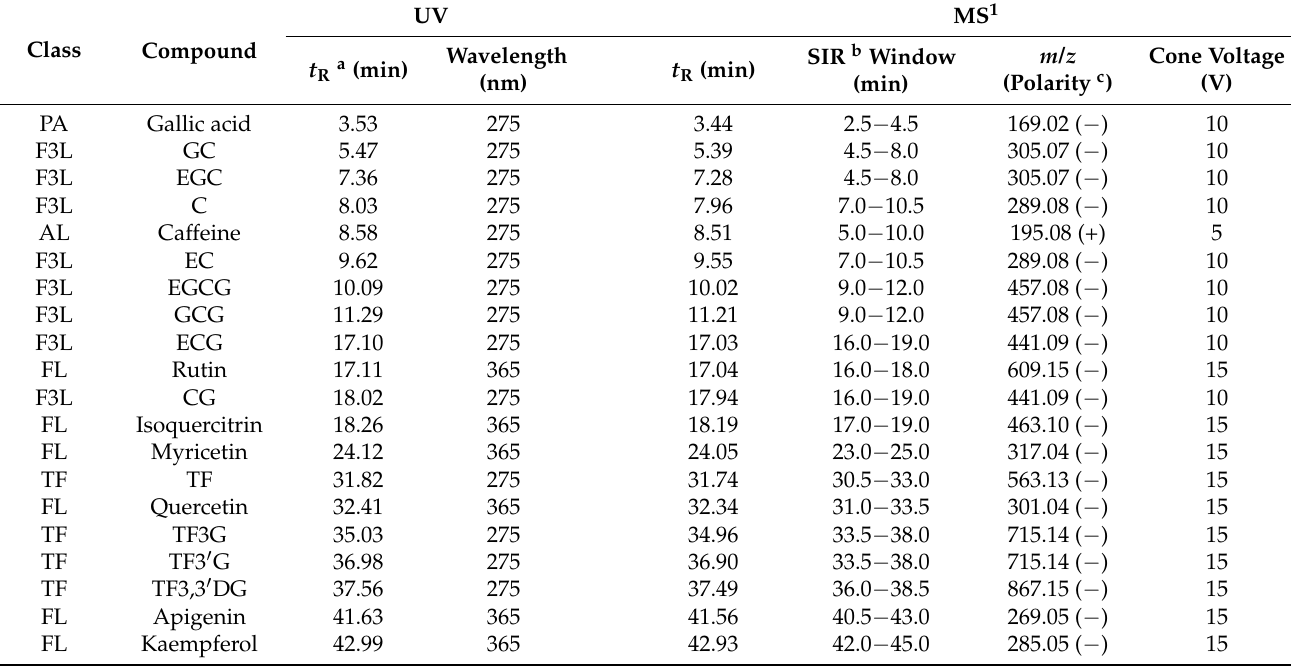
Figure 3. Diagram of an HPLC–UV system coupled to a single-quadrupole mass spectrometry (MS 1 ) detector system. A, B, and C denote solvents used in the mobile phase of HPLC and the isocratic solvent manager (ISM). Green numbers 1 and 5 indicate mean input, while green numbers 2 and 4 indicate mean output of flow portions in the ISM. Table 3. Parameters of 19 phenolic and caffeine compounds obtained using UV and MS 1